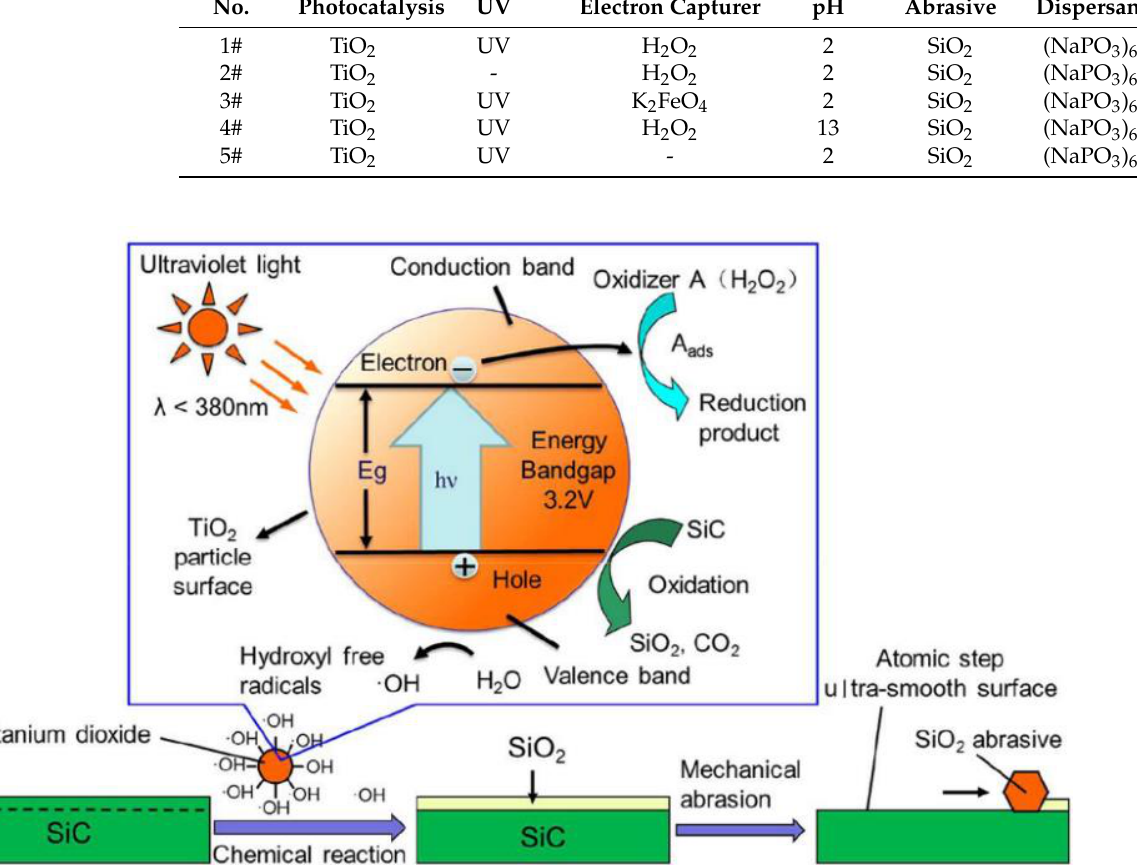
Figure 12. Schematic diagram of the mechanism of SiC PCMP [14].